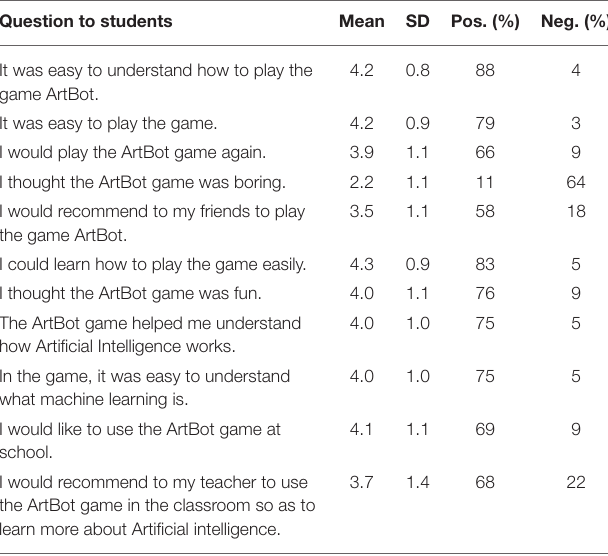
TABLE 2 | Likert scale questions asked to the students in the survey. Scores ranged from 1 (strongly disagree) to 5 (strongly agree). Question to students Mean SD Pos. (%) Neg.